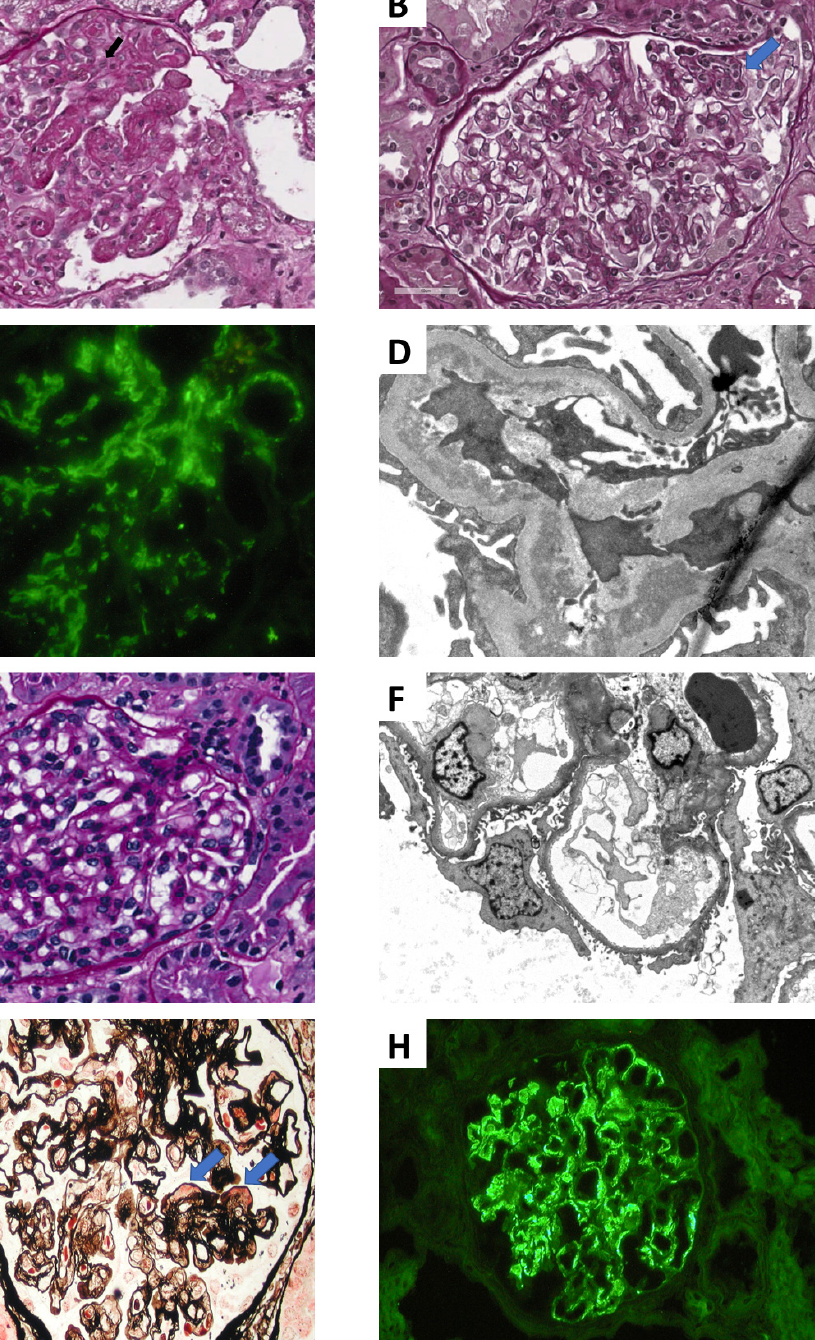
Figure 1. Glomerular fibrin and platelet thrombi in a patient with recurrent aHUS (PAS) ( A ). In a patient with early recurrent C3 glomerulonephritis the light microscopy ( B ) shows mild mesangial proliferation with segmental endocapillary hypercellularity (arrows, PAS staining). In this patient immunofluorescence shows only C3 mesangial staining ( C ) with electron dense deposits in mesangial and subendothelial spaces by electron microscopy ( D ). In a patient with early recurrent focal segmental